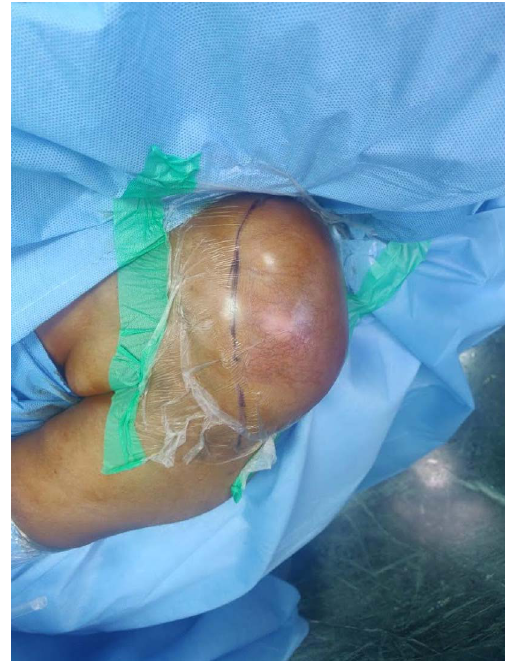
Figure 4. Surgical incision.